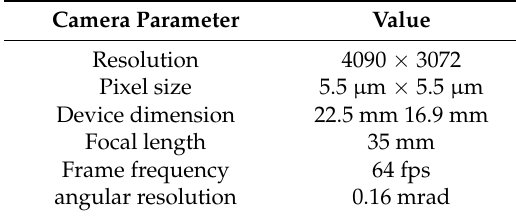
Table 1. Camera parameters of the high-resolution industrial CCD in System 1.